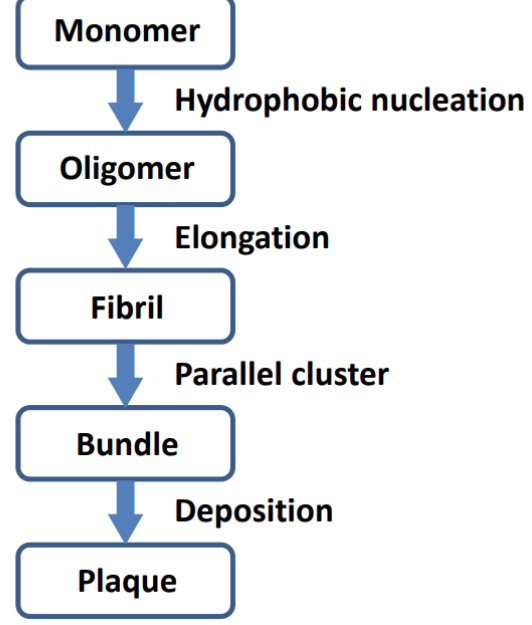
Figure 3. Schematic procedure of A β 42 aggregation. Table 1. The free energy of binding of the dipeptides from the poses shown in Supplementary Figure